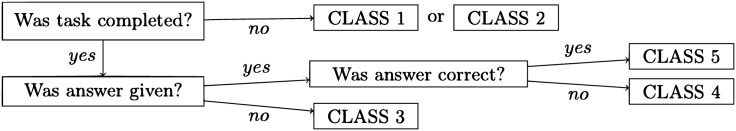
Partial dependencies of objective performance classes.